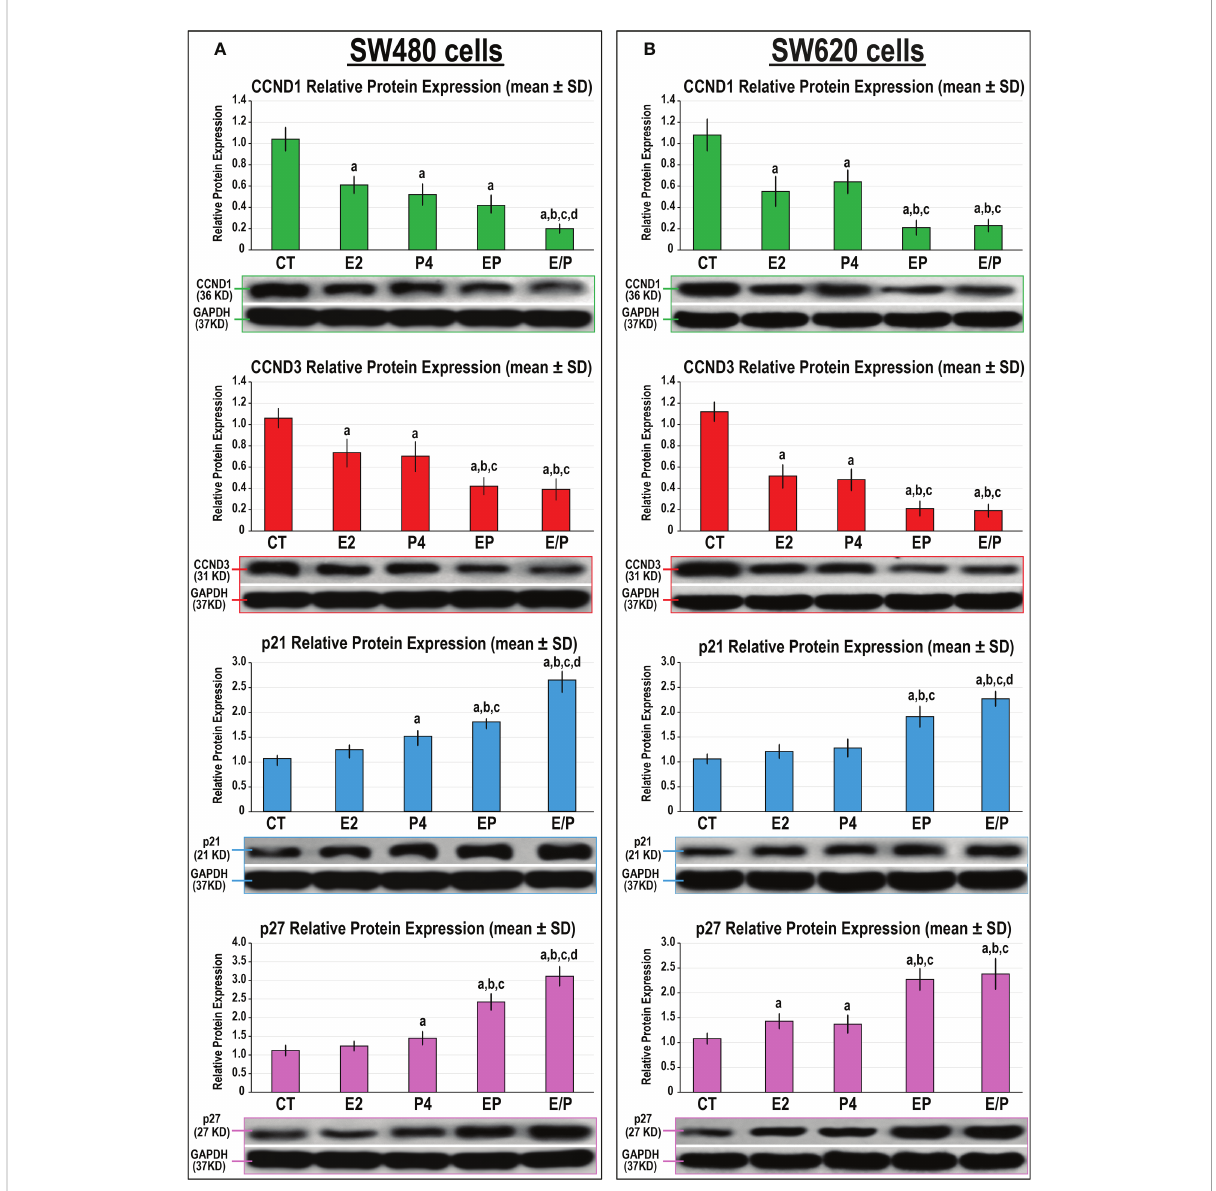
FIGURE 4 Detection of CCND1, CCND3, p21 and p27 proteins by Western blot alongside their relative protein expression (mean ± SD) following the different treatment protocols with E2 and/or P4 for 48 hours in the (A) SW480 and (B) SW620 male colon cancer cell lines (mean ± SD; a P< 0.05 compared with the CT group; b P< 0.05 compared with the E2 monotherapy group; c P< 0.05 compared with P4 monotherapy and d P< 0.05 compared with EP concurrent dual therapy